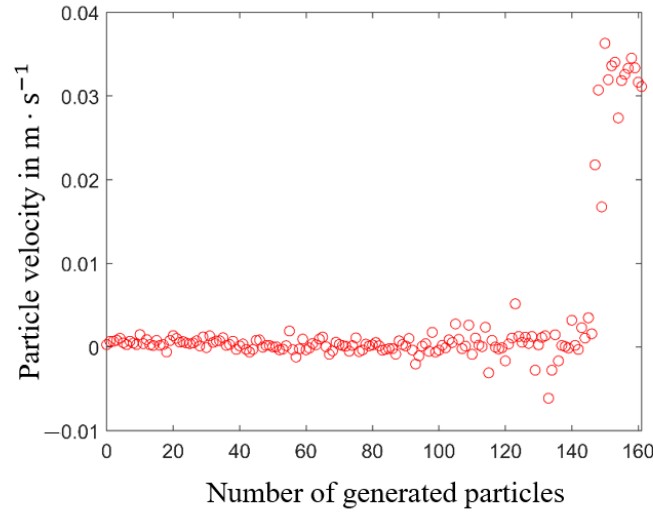
Figure 20. Particle velocities at the time point of 98 ms.